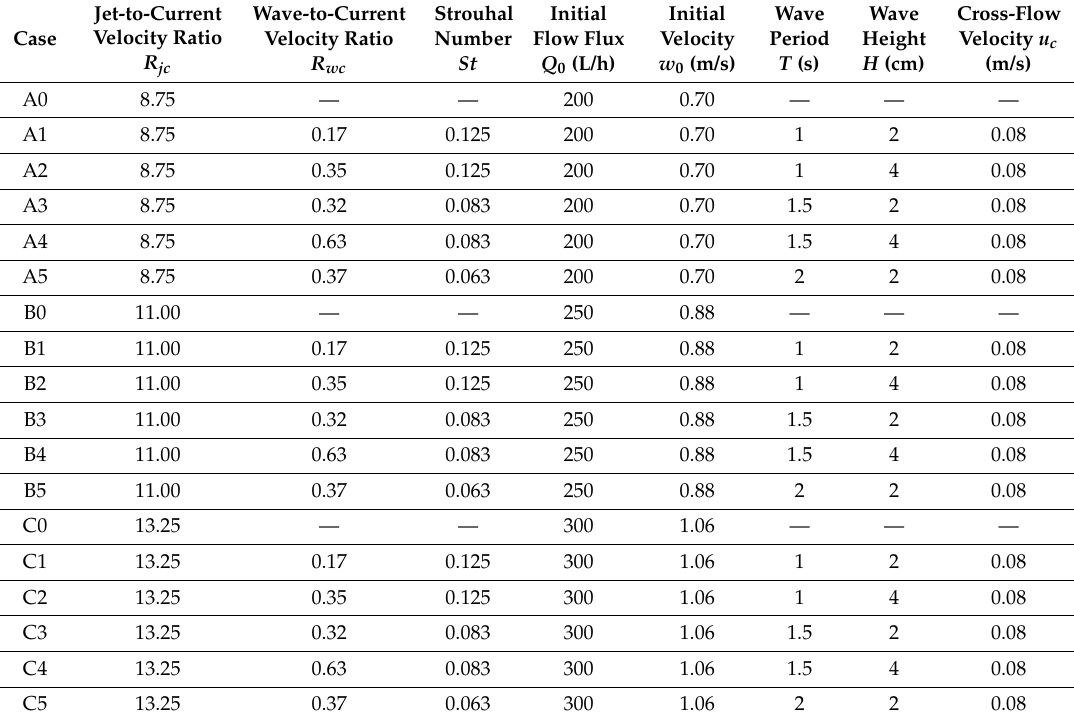
Table 1. Experimental jet, wave and cross-flow